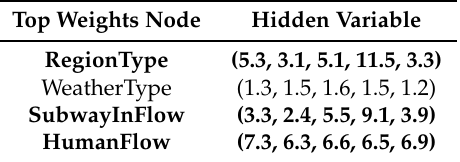
Table 7. Explanations of results based on propagation graph features for optimal store